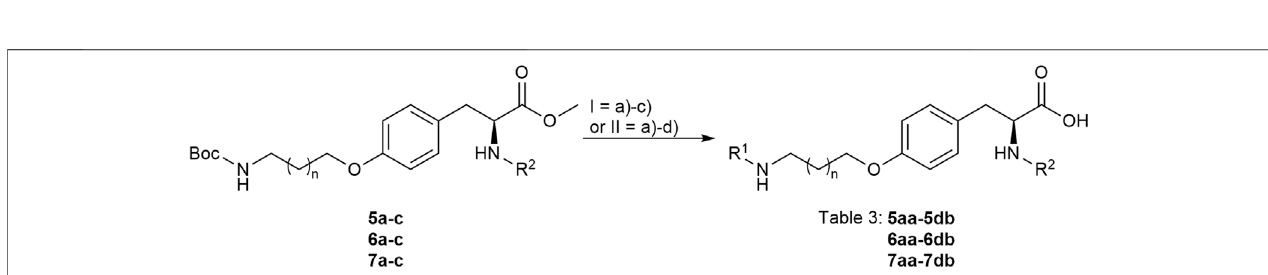
FIGURE 4 | Synthesis of RGD mimetic precursors 5a-c, 6a-c, and 7a-c. Reagents and conditions: a) 1. SOCl 2 , MeOH, and re fl ux; 2. Cbz-Cl, K 2 CO 3 , acetone, water, 0 ° C- > RT; b) DIAD, PPh 3 , THF, 0 ° C- > RT, o.n.; c) Boc 2 O, NEt 3 , RT, o.n.; d) Pd(OH) 2 /C, H 2 , MeOH/H 2 O 3:1, RT, o.n.; e) benzoic acid, HOBt, EDC, DIPEA, DMF, DCM, RT, o.n.and ; f) benzoyl chloride, DIPEA, DMC, DMF, RT, o.n.